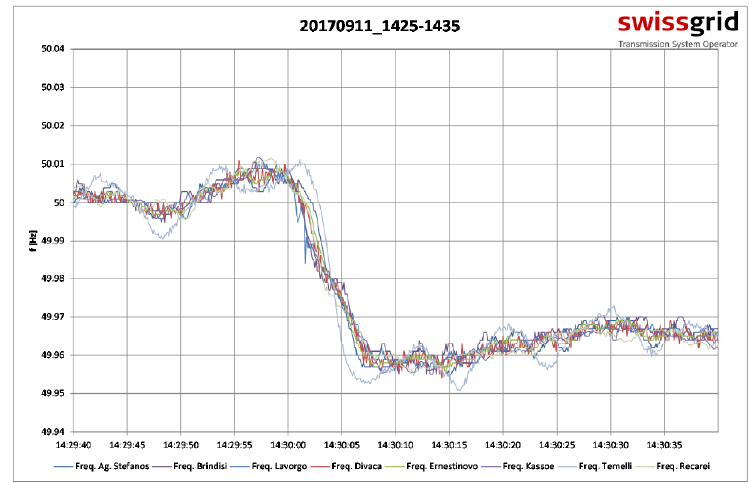
Figure 2. Frequency measurements by Swissgrid for forced outage of 1000 MW generation in Switzerland